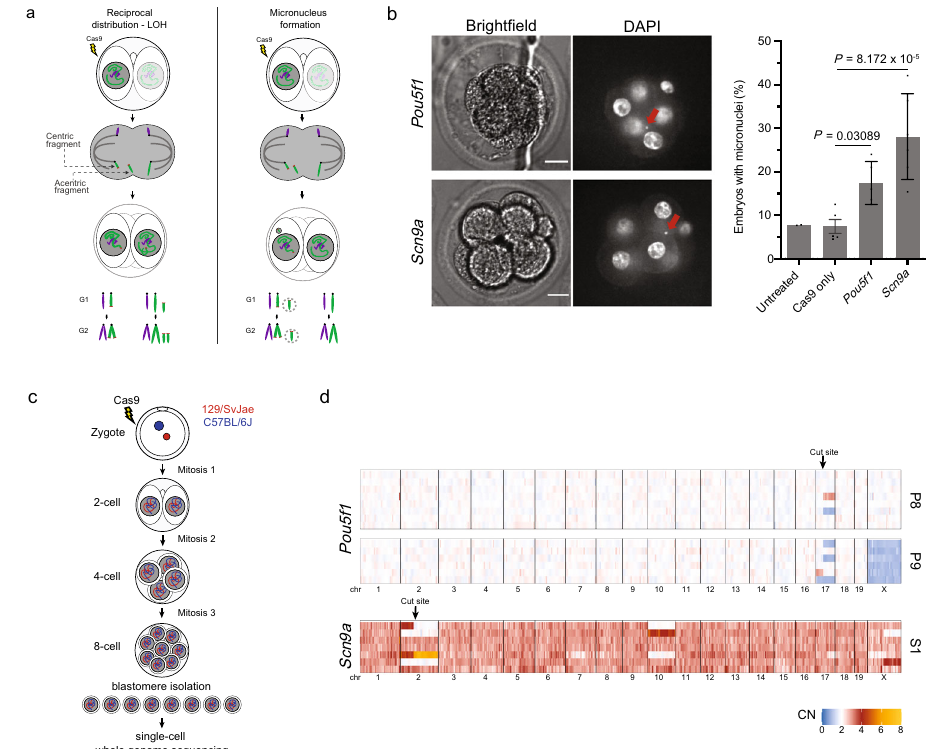
Fig. 1 Copy number alterations and micronucleation from CRISPR-Cas9 genome editing in mouse embryos. a Schematic of two chromosome segregation errors following Cas9 treatment in cleavage stage mouse embryos. Left, missegregation of the Cas9-induced acentric fragment to one daughter and segregation of the centric fragment to the other generates a reciprocal gain/loss copy number (CN) pattern. LOH is loss of heterozygosity. Right, the acentric fragment segregates to the same daughter as the centric fragment but is partitioned into a micronucleus. Because of defective DNA replication in the micronucleus, in G2 cells, the acentric fragment will have ~0.5 CN of the centric fragment. Targeted chromosome: green; normal chromosome: purple. Cas9 cut site is marked in red. b Micronucleus formation after CRISPR-Cas9 treatment. Left, representative single z-focal plane confocal images of 8-cell stage mouse embryos after CRISPR-Cas9 with Pou5f1 and Scn9a gRNAs that are quanti fi ed in the right panel. Red arrows: micronuclei. Right, percentage of 8-cell stage embryos with at least one micronucleus ( n = 2, 5, 5, 6 experiments with 77, 97, 136, and 99 embryos, left to right). Error bars: mean ± SEM, two-tailed Fisher ’ s exact test against the “ Cas9 only ” group. Scale bars: 15 μ m. Source data are provided as a Source Data fi le. c Schematic of the experimental strategy for single-cell whole-genome DNA sequencing. d Heatmap representing total CN for each chromosome for the P8 and P9 embryos after CRISPR-Cas9 treatment with the Pou5f1 and S1 with the Scn9a gRNAs. Bin size: 5 Mb. Arrows indicate the genomic location of the targeted cleavage site for the indicated gRNAs. Note: the S1 embryo is triploid (see main text and Supplementary Data